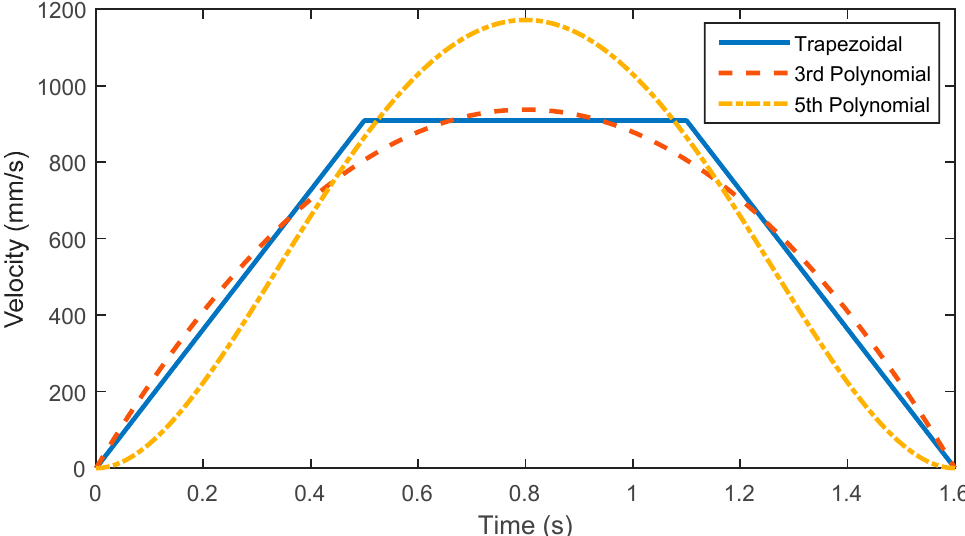
Figure 2. Comparison of trapezoidal motion profile, 3rd-order polynomial trajectory, and 5th-order polynomial trajectory with the same duration of motion.